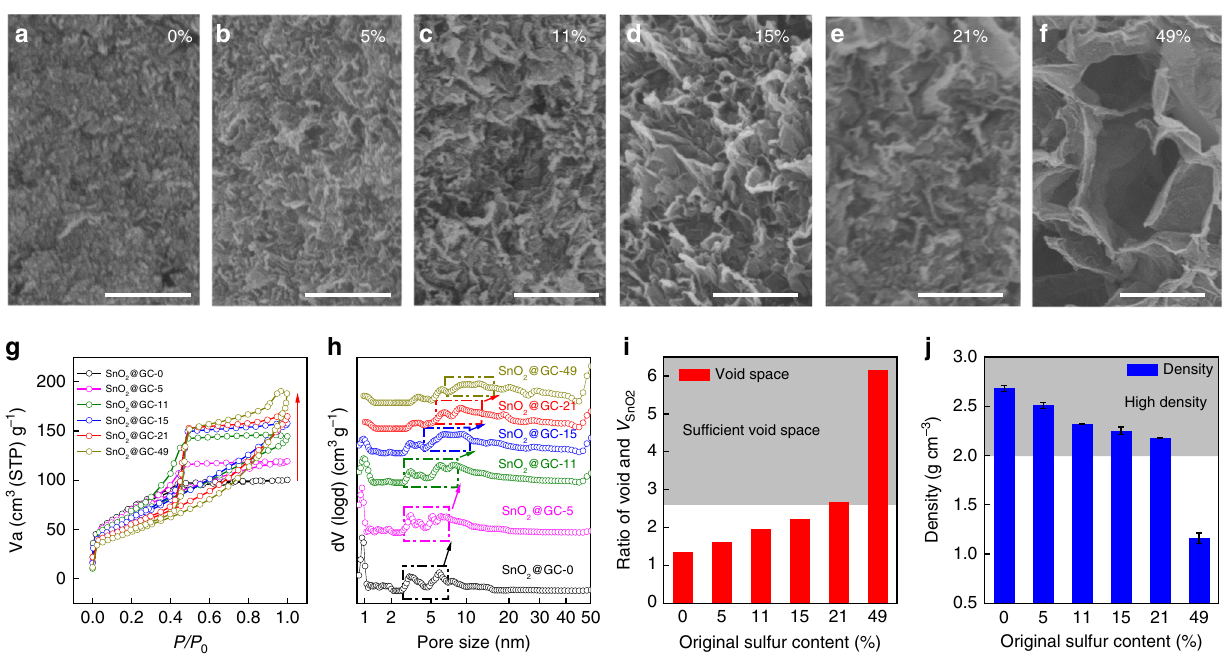
Fig. 3 Tuning the void space of SnO 2 @GCs at the nanoscale. a – f SEM images showing the more expanded structure of SnO 2 @GCs containing increasing amounts of sulfur (0, 5, 11, 15, 21, 49%) after it has all been removed. g Nitrogen adsorption – desorption isotherms, and h pore size distributions of SnO 2 @GCs showing that the pore structure changes and pore size increases as the original sulfur content increases. i Calculated void space and j density changes as a result of removing the sulfur from the six samples. Error bars indicate s.d. ( n = 3). Scale bars: a – f 500